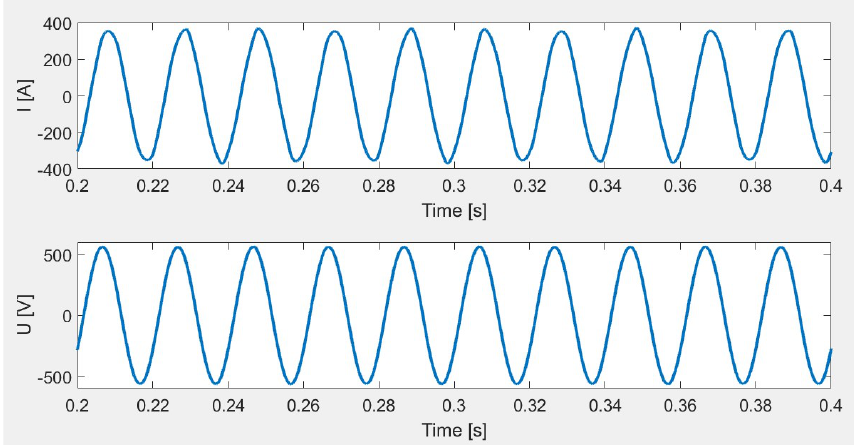
Figure 14. Current and voltage recorded at the point of connection of four 40 kW vehicle-to-grid (V2G) DC chargers.